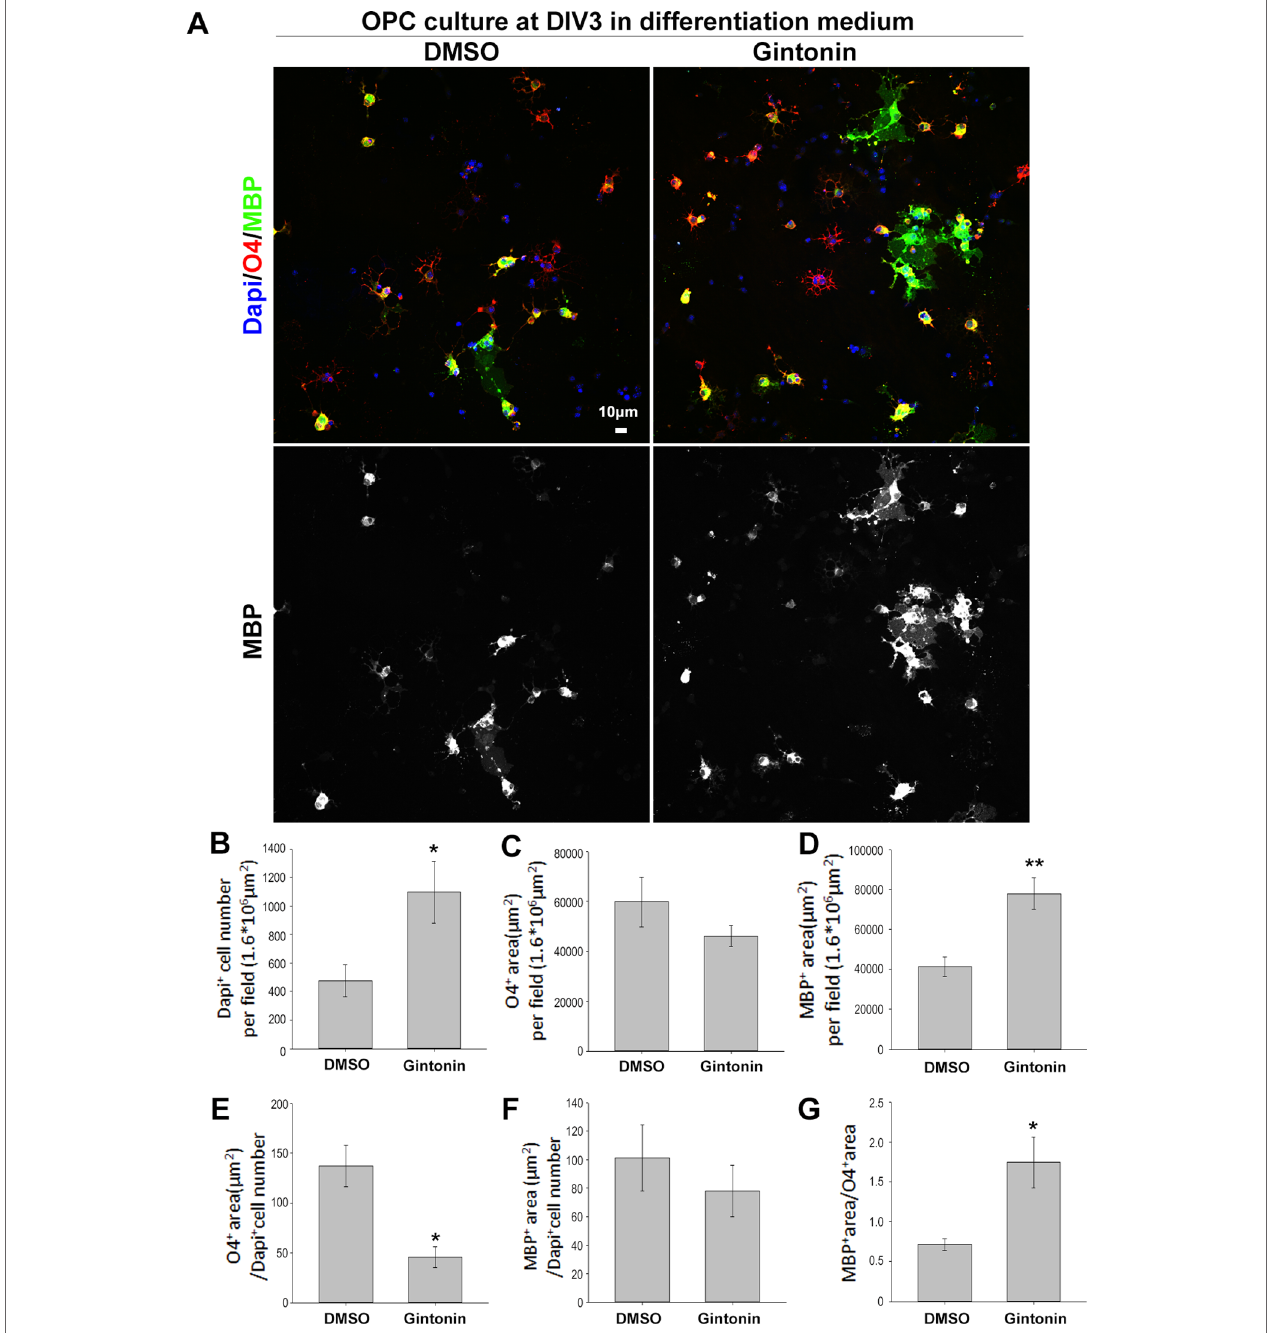
FIGURE 4 | Gintonin facilitates the late stage differentiation of oligodendrocytes. (A) For stage-specific differentiation analysis, pure OPC cultures treated with gintonin (10 μg/ml) or DMSO from DIV1 were lively stained at DIV3 with O4 antibodies (a marker for oligodendrocytes from immature stage, red), then allowed to fix for MBP (a mature oligodendrocyte marker, green) and DAPI (a nucleic marker, blue) staining. Scale bar ＝ 10 µm. (B) In differentiation medium, DAPI+ cell number per field was significantly increased by gintonin treatment (* p < 0.05). (C) O4+ area per field by gintonin treatment. (D) MBP+ area per field was significantly enhanced by gintonin (** p < 0.01). (E) O4+ area per DAPI+ cell number (* p < 0.05). (F) MBP+ area per DAPI+ cell number. (G) MBP+ area per O4+ area was calculated as late differentiation ratio and was significantly increased by gintonin treatment (* p < 0.05). Bars represent mean ± S.E.M. Two-tailed unpaired Student’s t -test, N =